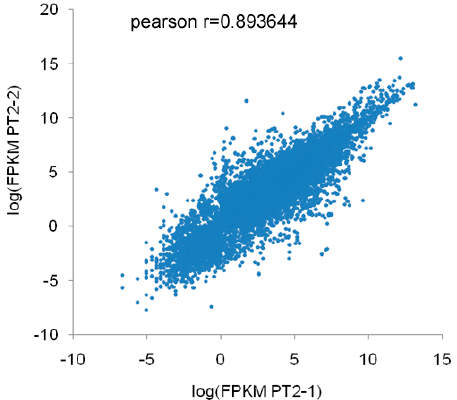
Figure 2. Correlation coefficients of the gene expression of duplicate samples. X-axis represents the logarithmic value of diploid P. tomentosa (PT2) expression, while Y-axis represents the logarithmic value of the corresponding duplicate